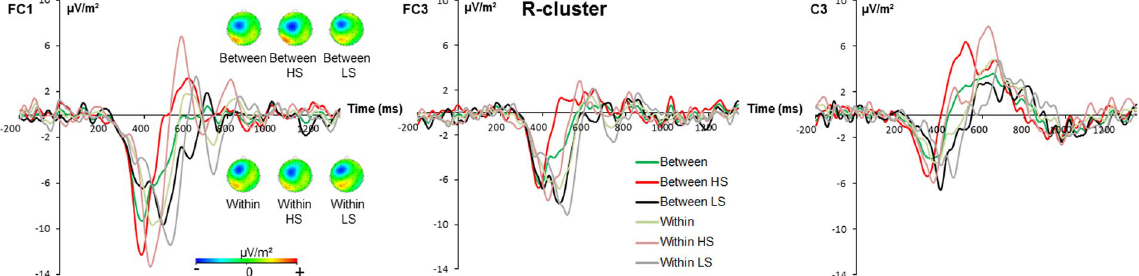
Figure 4. The R-cluster at electrodes FC1 (left), FC3 (middle) and C3 (right) is shown for the within-hand and the between-hands condition in GO trials for the total sample (green and light green lines) as well as for the high (HS) and the low (LS) suppression group. In all plots time point 0 marks stimulus presentation. The scalp topography plots represent the R-cluster in GO trials at the time point of response execution. Red color represents positive values and blue color negative